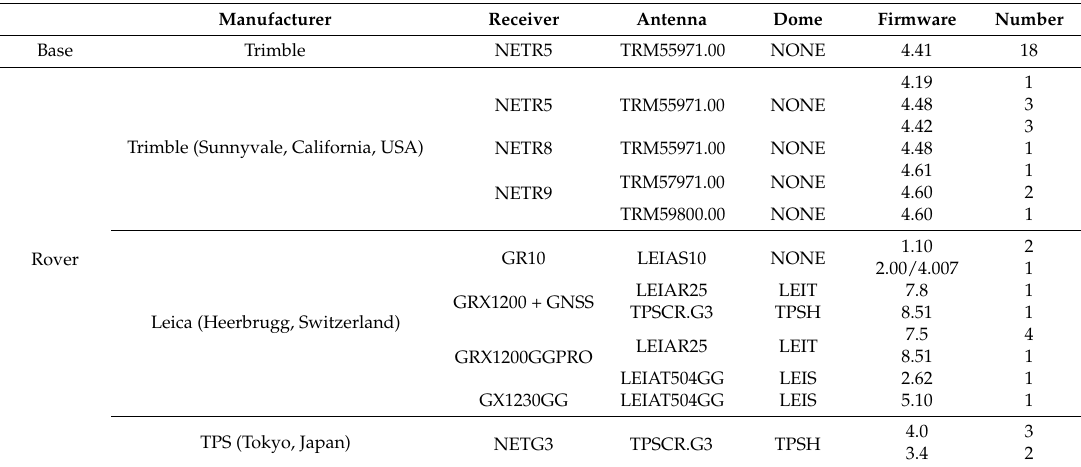
Figure 2. Distribution of 18 base stations and 29 rover stations used in France.